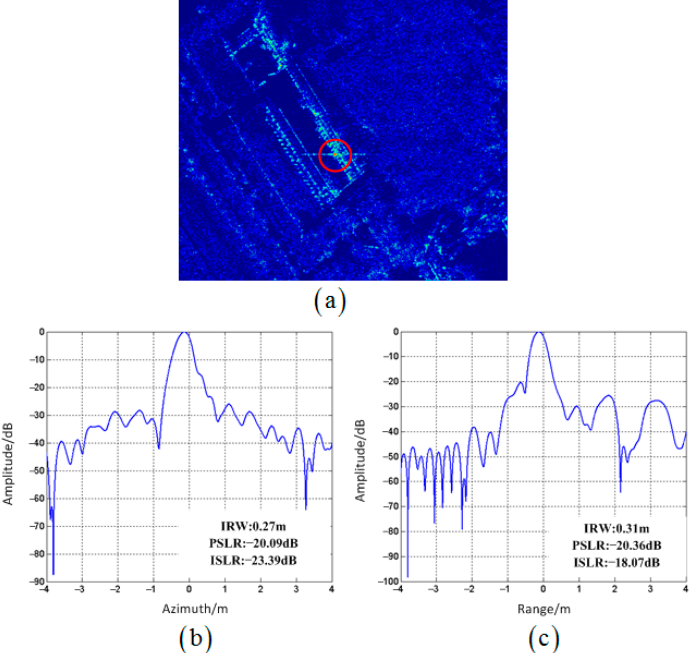
Figure 24. The imaging result of a single image. ( a ) The zoom-in imaging result and the target point are marked by the red circle. ( b ) Azimuth profile and measured parameters of target point. ( c ) Range profile and measured parameters of target point.